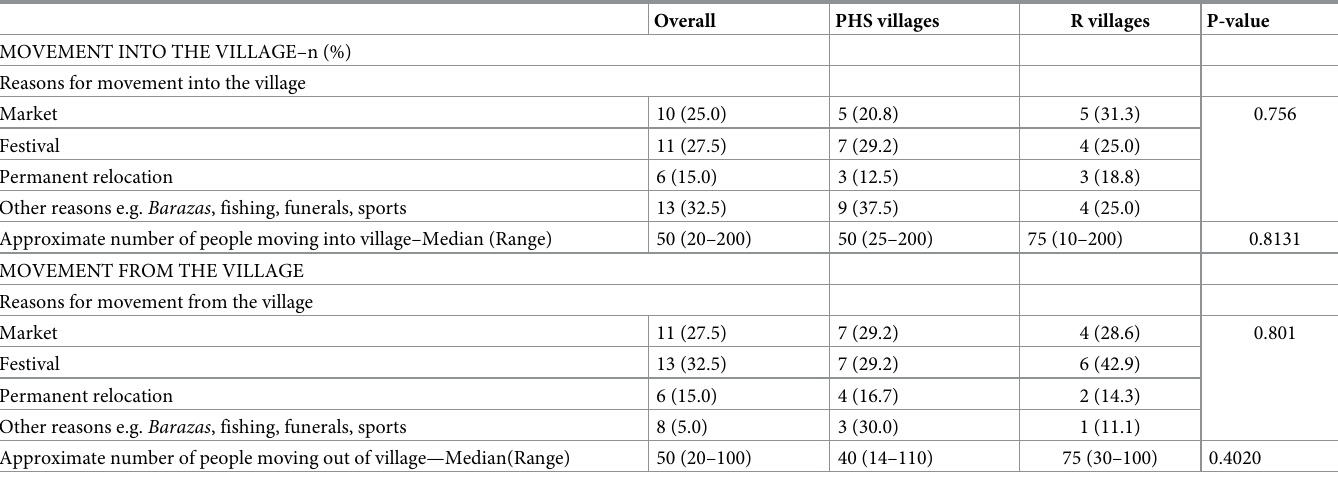
Table 3. Migration into and out of the PHS and R